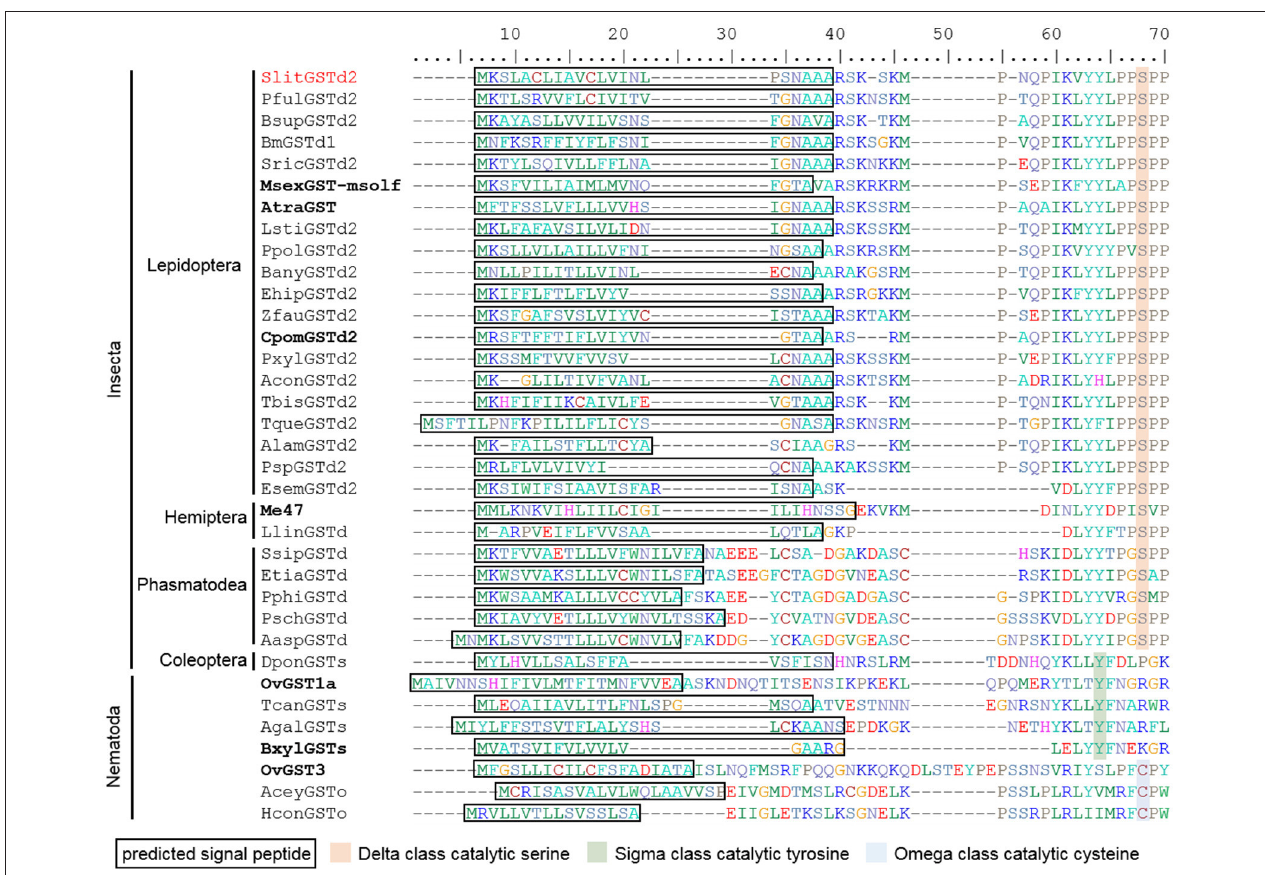
FIGURE 3 | Partial alignment of 35 GSTs from insects and nematodes showing several sequences from delta, sigma and omega classes with predicted signal peptides. Each sequence is representative of one family. Slit, Spodoptera littoralis ; Bsup, Biston suppressaria ; Msex, Manduca sexta ; Atra, Amyelois transitella ; Bany, Bicyclus anynana; Ehip, Eogystia hippophaecolus; Zfau, Zygaena fausta ; Cpom, Cydia pomonella ; Pxyl, Plutella xylostella ; Tbis, Tineola bisselliella ; Tque, Tischeria quercitella ; Alam, Andesiana lamellata ; Psp, Ptyssoptera sp.; Esem, Eriocrania semipurpurella ; Llin, Lygus lineolaris ; Meup, Macrosiphum euphorbiae ; Ssip, Sipyloidea sipylus ; Pphi, Phyllium philippinicum ; Aasp, Aretaon asperrimus ; Psch, Peruphasma schultei ; Dpon, Dendroctonus ponderosae ; Ovol, Onchocerca volvulus ; Tcan, Toxocara canis ; Agal, Ascaridia galli ; Bxyl, Bursaphelenchus xylophilus. BxylGSTs full name is BUX.s000647.112 ( Espada et al., 2016a). Identifiers in bold indicate sequences linked to representative publications. Pful, Phragmatobia fuliginosa ; Bm, Bombyx mori ; Sric, Samia ricini ; Lsti, Loxostege sticticalis ; Ppol, Papilio polytes ; Acon, Argyresthia conjugella ; Etia, Extatosoma tiaratum